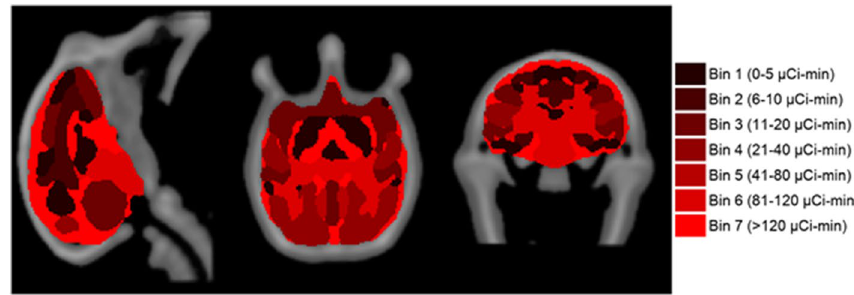
Fig. 3 Representative image of the mean AUC distribution throughout the